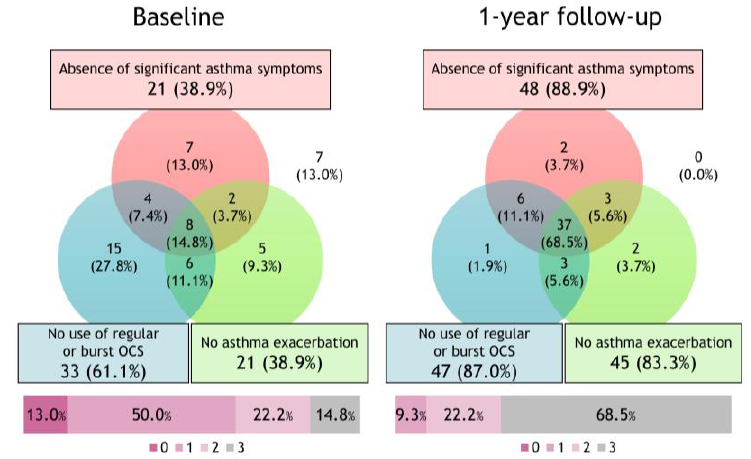
Figure 1. Changes in clinical remission subtypes after initiating biologics. The Venn diagram and percentage of patients achieving the three components of clinical remission before and after the initiation of biologics. With the initiation of biologics, the proportion of patients in clinical remission increased from 14.8% to 68.5%.